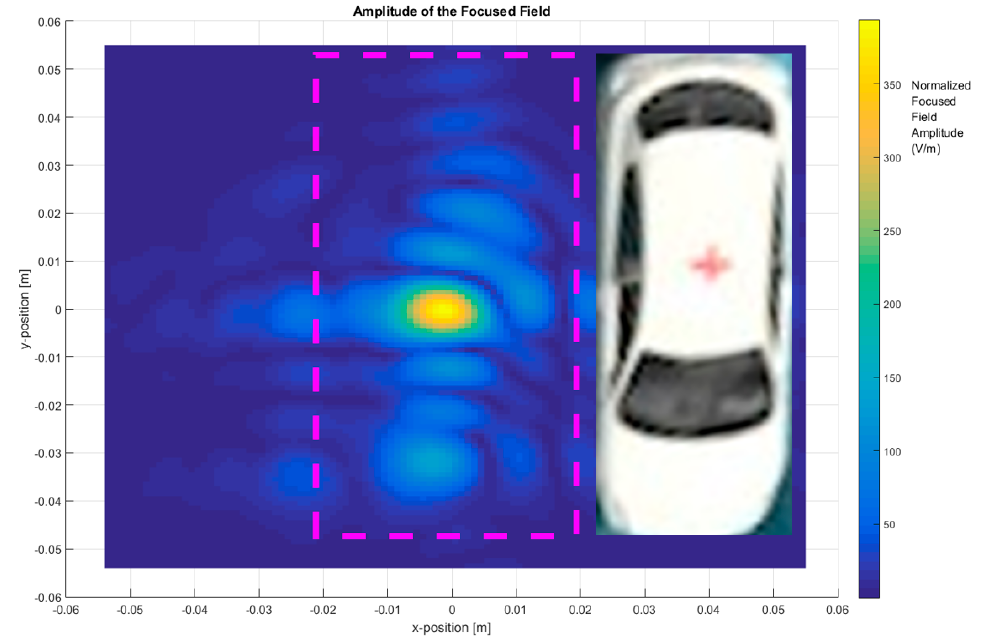
Figure 3. A metallic car with an antenna for differential imaging.